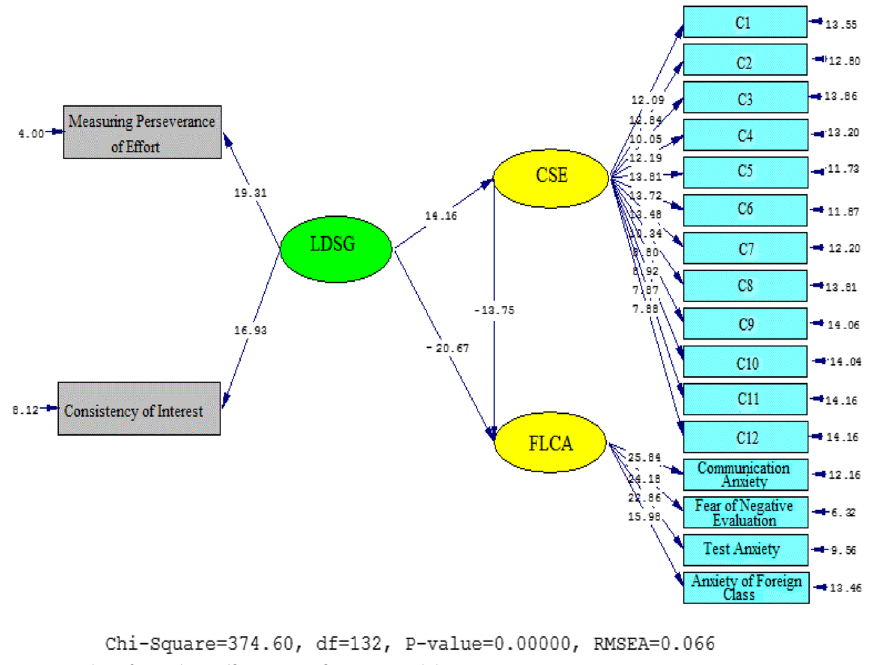
Fig. 3 T Values for path coefficient significance (model 1)